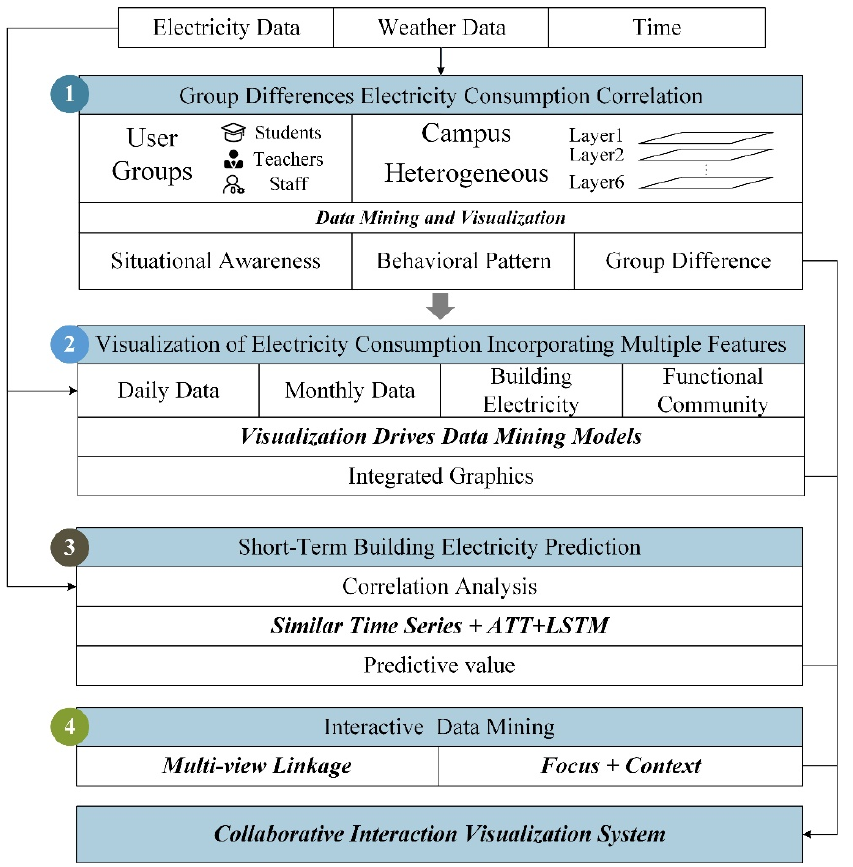
Figure 2. A visual analytics framework for integrated visualization of electricity consumption data.